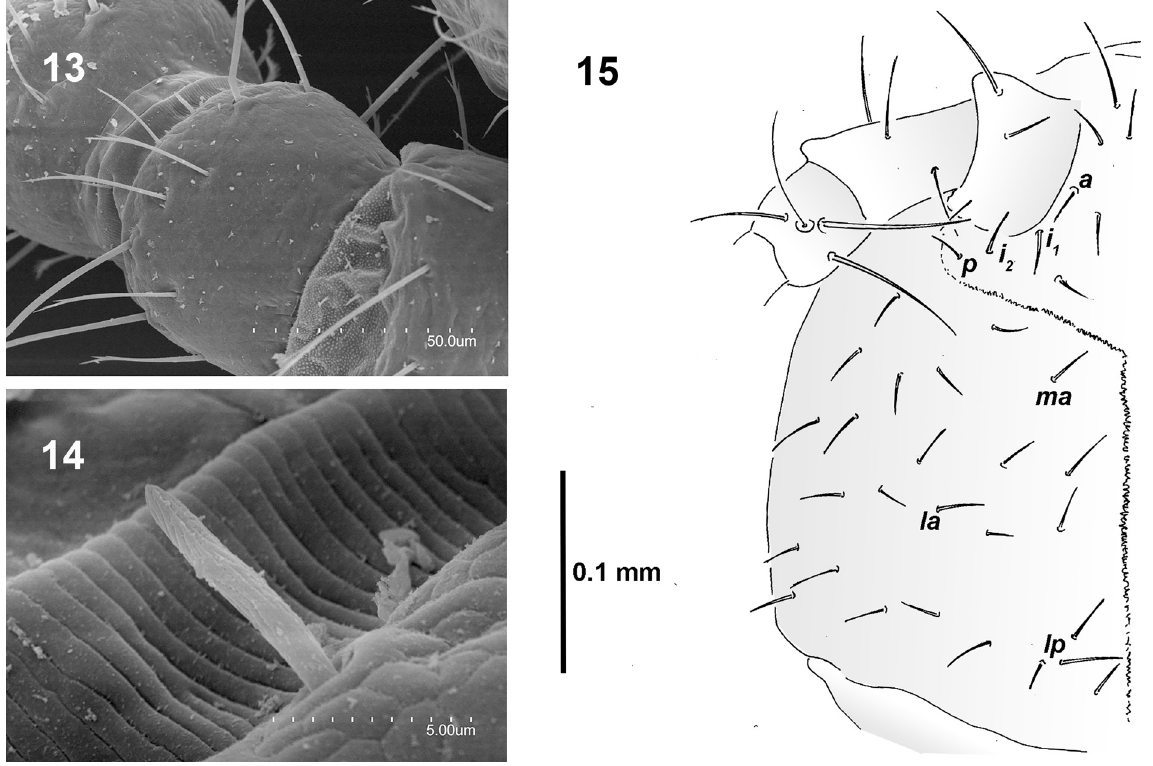
Figs 13−15. Kyrgyzstancampa sanare Sendra & Ferreira gen. et sp. nov. 13 . ♂, paratype (Coll. AS), 3 rd antennomere. 14 . ♂, paratype (Coll. AS), sensillum of 3 rd antennomere. 15 . ♀, holotype (IBB 92101), left portion of the head at dorsal